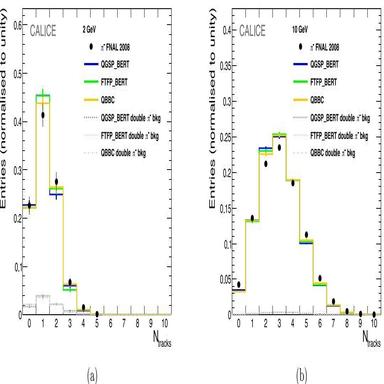
Number of secondary tracks for energies of 2 GeV (a) and 10 GeV (b) of the beam energy. Other details follow those of.